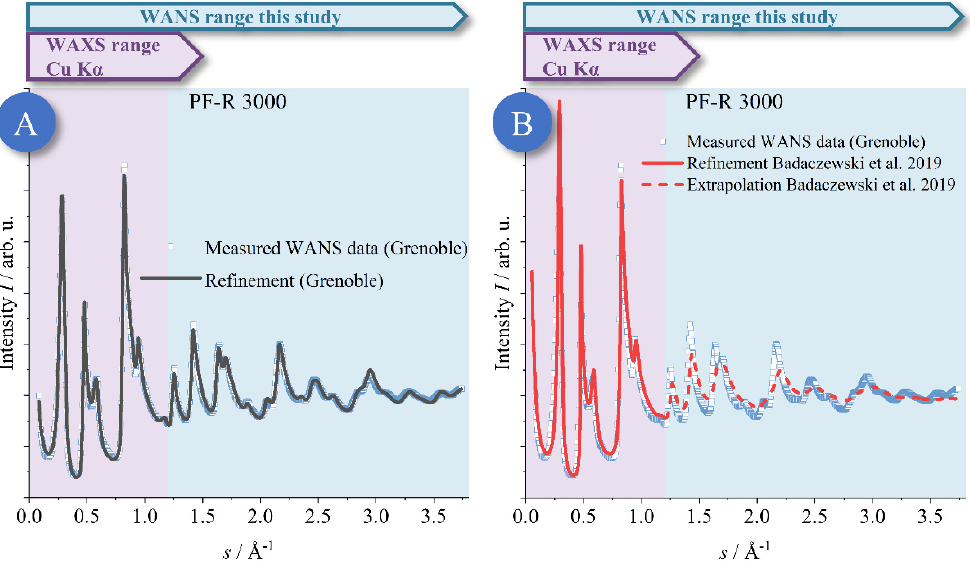
Figure 8. ( A ): Measured and refined WANS data of PF-R 3000. ( B ): Measured WANS data with simulated WANS data calculated from the WAXS refinement of Badaczewski et al. [37]. The dotted curve means an extrapolation in the range of large s , which was not measured in the reference.